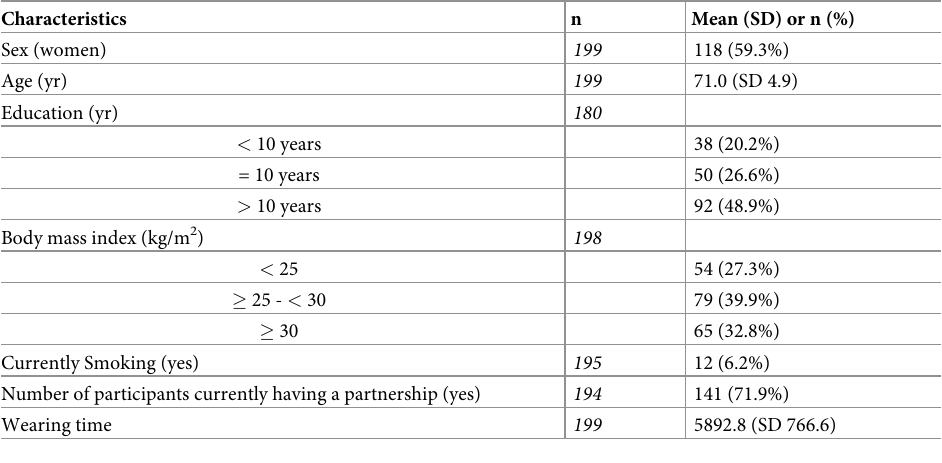
Table 1. Descriptive characteristics of the study sample (n = 199).